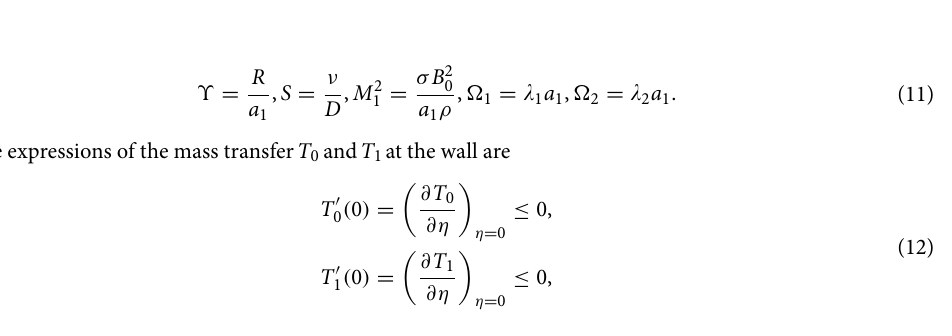
Table 1. Comparison of the variation of surface mass transfer − T ′ 0 ( 0 ) and − T ′ 1 ( 0 ) for some values of Sc , ϒ , M (cid:31) 1 = (cid:31) 2 with published work 21